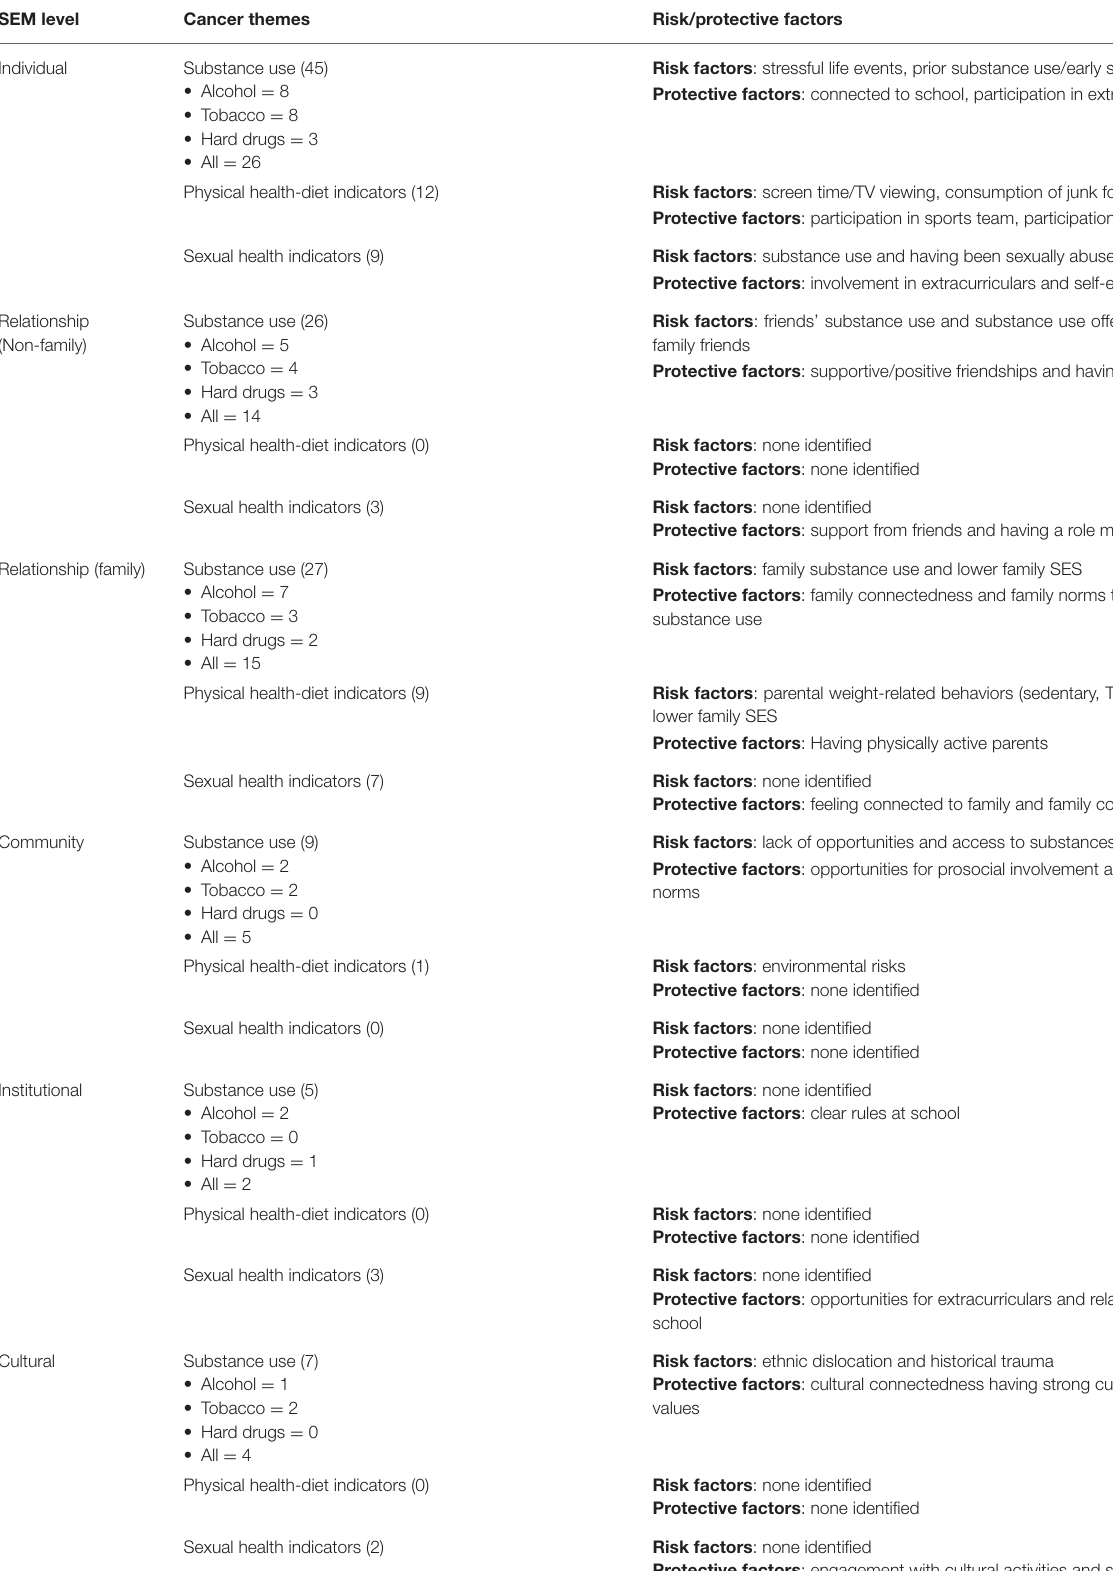
Risk factors : none identified Protective factors : engagement with cultural activities and spiritual